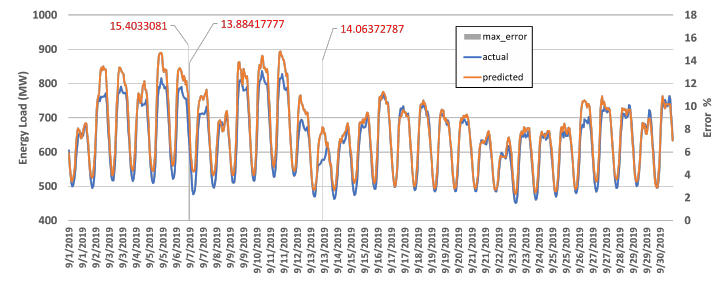
Figure 19. Peak errors recorded in the month of September